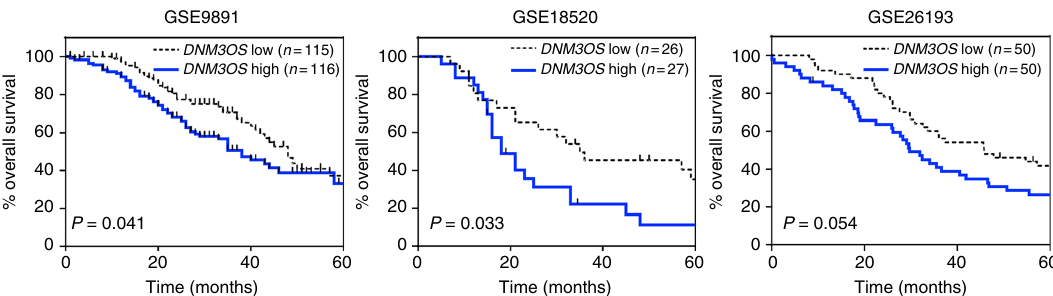
Fig. 4 Elevated DNM3OS expression signi fi cantly correlates with poor overall survival of ovarian cancer patients. For individual data sets, ovarian cancer patient samples were separated into DNM3OS high and DNM3OS low based on the median expression of DNM3OS , and Kaplan – Meier survival analyses were performed. P -values determined by